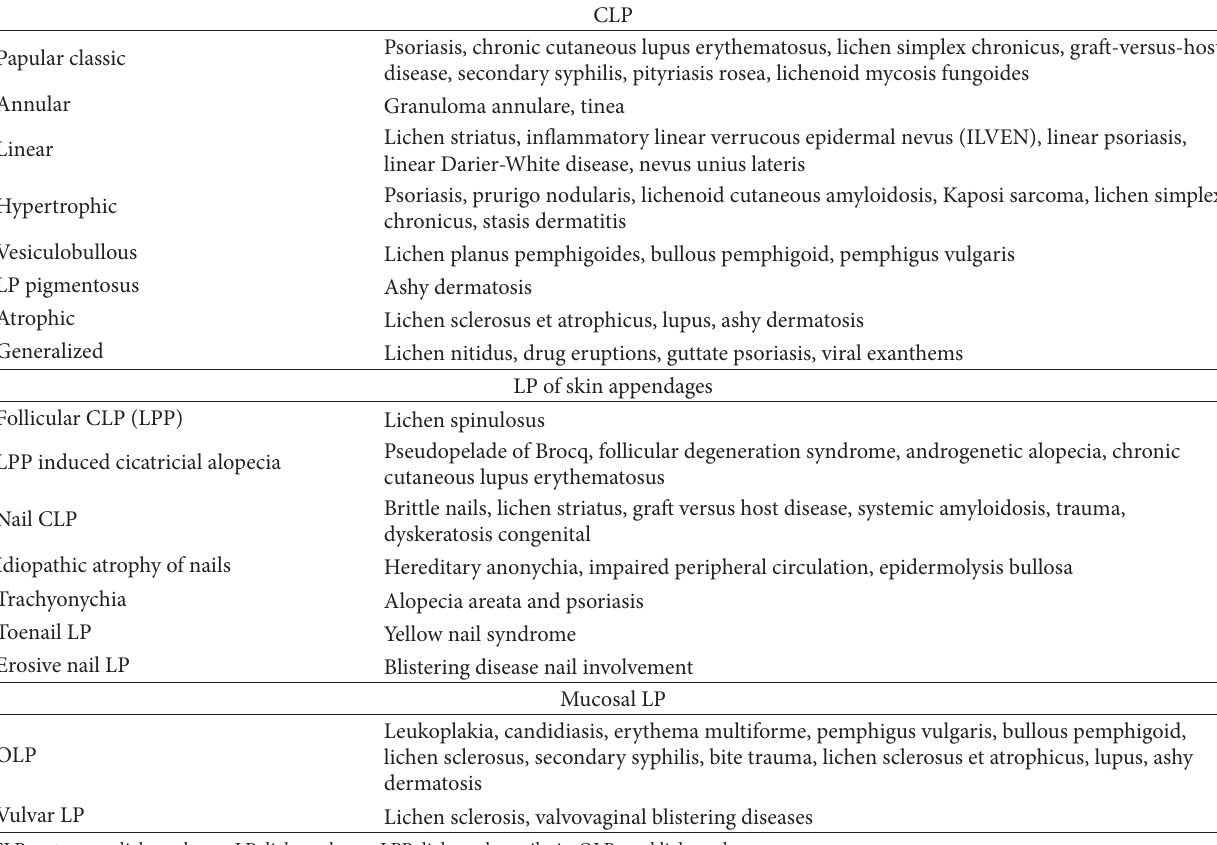
Table 2: LP differential